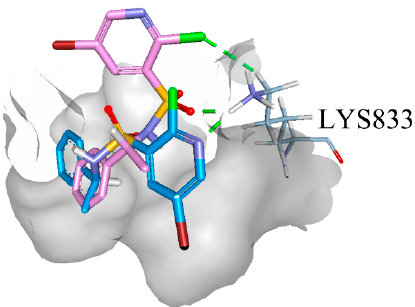
Figure 10. The PI3K γ active site in complex with compound 10a (pink) and 10b (blue).